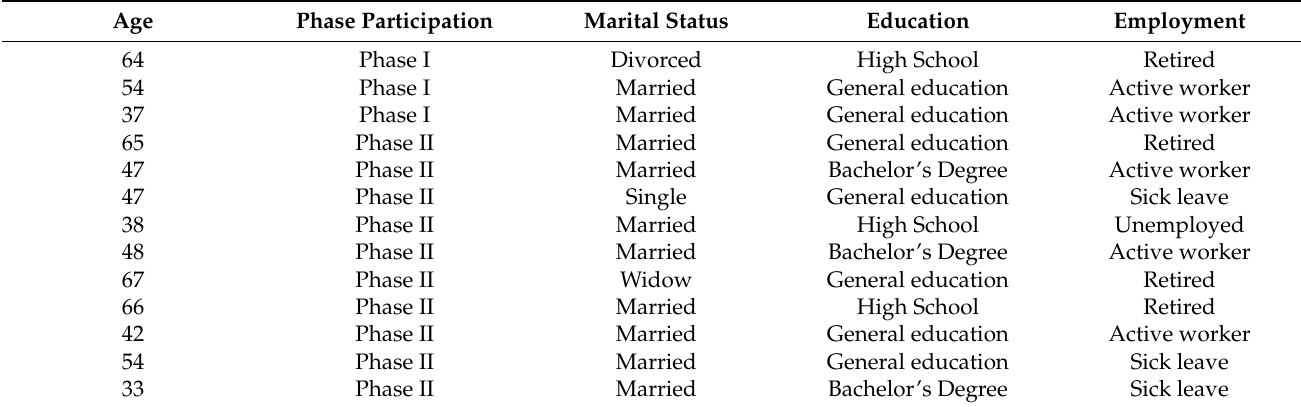
Table 1. Participant